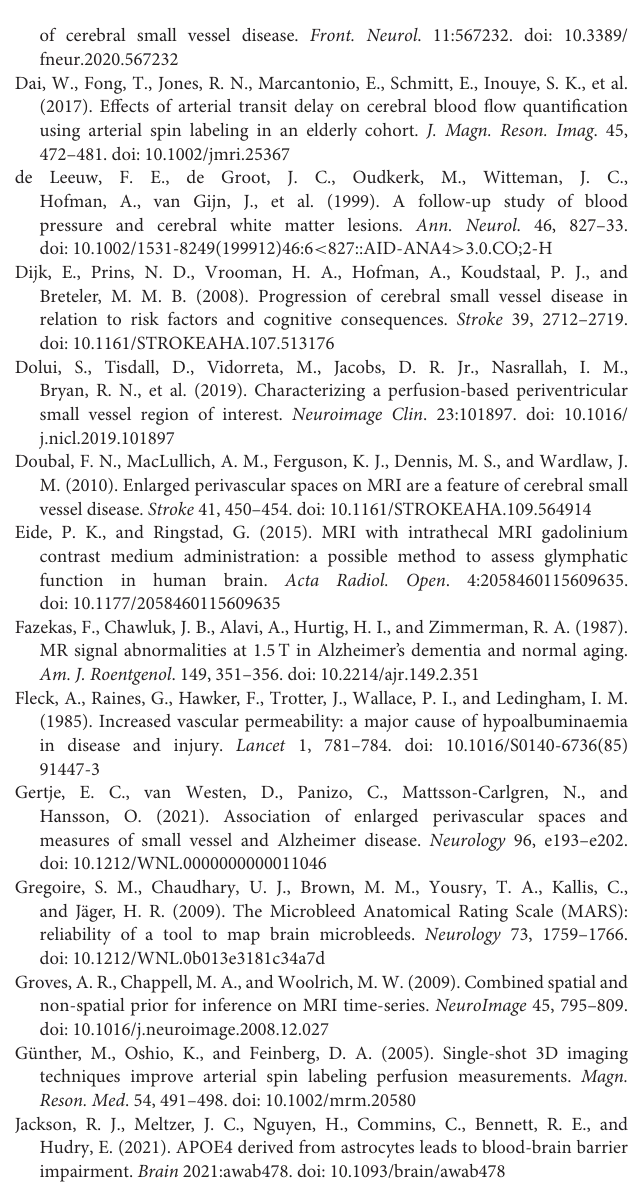
(WMH-Faz) and Charidimou (WMH-Cha), lacunes, lobar and deep lacunes, total number of enlarged perivascular spaces (EPVSs) in the basal ganglia, centrum semiovale, and hippocampus (EPVS), EPVSs in the centrum semiovale and basal ganglia (EPVS-CSO and EPVS-BG), microbleeds (CMBs), lobar and deep CMBs, mean cerebral blood flow (CBF), mean arterial transit time (ATT) and mean effective T1-relaxation time (T1eff) in gray matter (GM), WM, basal ganglia (BG), and for the perfusion results additionally for the left hippocampus (HCl) and right hippocampus (HCr). Shown are positive (red) and negative (blue) correlation coefficients between all parameters. Supplementary Figure 2 | Axial slice of the MPRAGE (A) , FLAIR (B) , and cerebral blood flow (CBF) result (C) of a representative patient (ID = 5). Estimated CBF results (in structural space) before a partial volume correction was applied are shown, to visualize gray and white matter values within the same image. Supplementary Table 1 | Demographical information and individual study results used for statistical